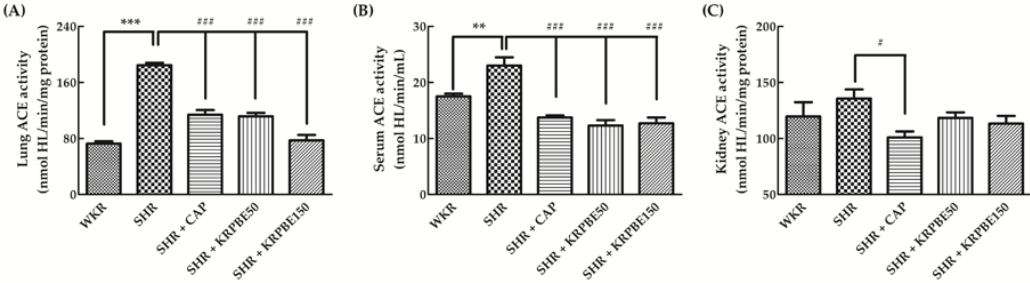
Figure 2. Angiotensin-converting enzyme (ACE) activities in lungs ( A ), serum ( B ), and kidneys ( C ) of WKRs and SHRs after seven weeks of oral administration. WKR group (tap water), SHR group (tap water), SHR + CAP group (15 mg/kg body weight/day of CAP), SHR + KRPBE50 group (50 mg/kg body weight/day of KRPBE), and SHR + KRPBE150 group (150 mg/kg body weight/day of KRPBE) were orally administrated for seven weeks. ACE activity was determined using His-Leu (HL) standard calibration curve. Each group consists of six rats. Tukey–Kramer honestly significant difference test: ** p < 0.01, *** p < 0.001 vs. WKR and # p < 0.05, ### p < 0.001 vs. SHR.